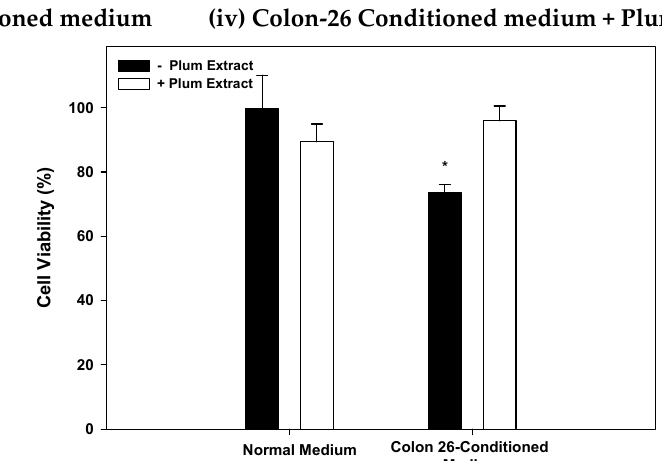
Figure 8. The effect of plum extract on C2C12 viability in response to Colon-26-induced cytotoxicity. ( a ) Differentiated C2C12 myotubes were treated with normal medium (i & ii) or Colon-26-conditioned medium (iii & iv) in the absence (i & iii) or presence (ii & iv) of plum extract (50 µg/mL). ( b ) The viability of C2C12 myotubules were determined using WST-1 assay. The data is expressed as mean ± SD for at least three experiments. All comparisons were made to control (untreated cells) using one-way ANOVA; significant differences are reported at * p < 0.05.